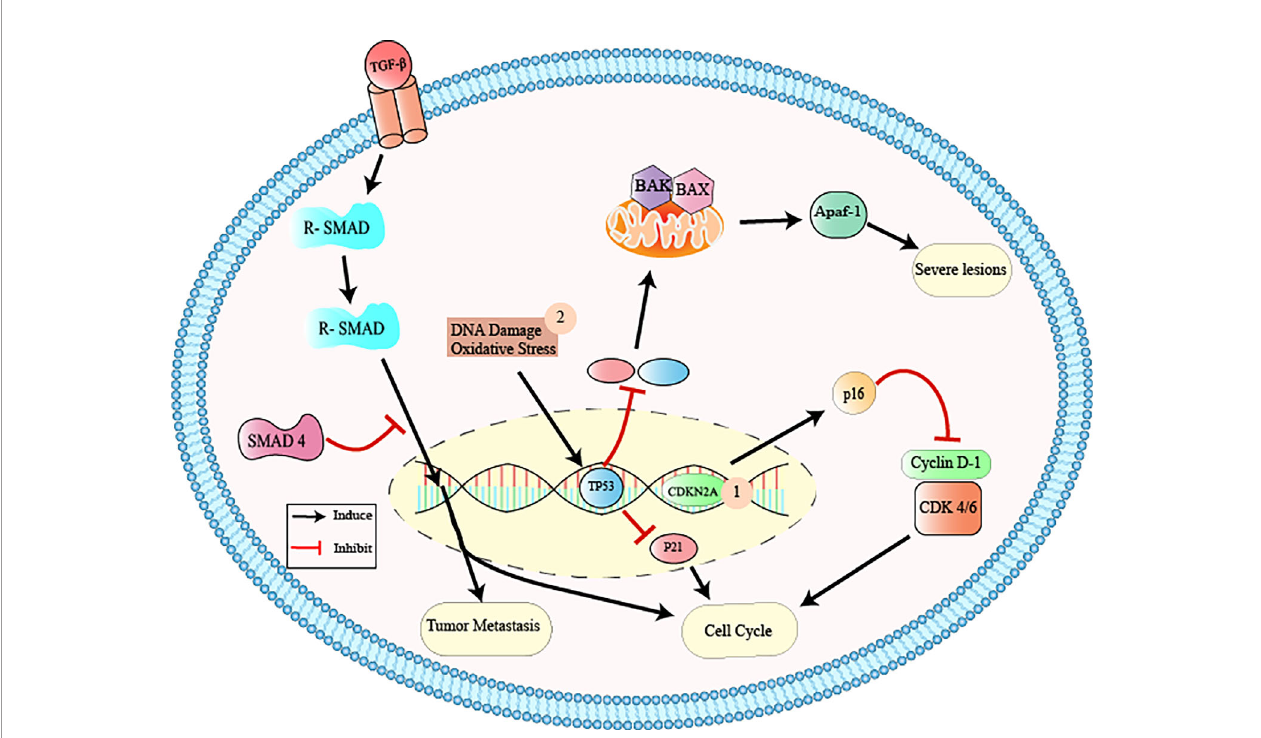
FIGURE 2 | Inactivation of tumor suppressor genes via CDKN2A, TP53, and SMAD4. 1: CDKN2A (cyclin-dependent 2K kinase inhibitor) is a tumor suppressor gene that is found to be mutated usually in PanIN-2 lesions. This gene encodes the p16 protein that binds to cyclin dependent kinase 4/6 (Cdk4/6), interrupting the cell cycle in the G1 phase. The inactivation of CDKN2A causes the functional deactivation of the p16 protein and, consequently, increased cell proliferation, contributing to tumor formation and growth; 2: TP53 (tumor protein p53) is the tumor suppressor gene that activates target genes (p21, Bax, Apaf-1) in response to cell oxidative stress and DNA damage, participating in the control of cell growth and apoptosis through gene transcription. The inactivation of this gene causes dysregulation of the cell cycle and worsening of neoplastic lesions; 3: The SMAD4 (mothers against decapentaplegic homolog 4) is located on chromosome 18q and encodes the beta transcription factor (TGF-b) involved in the regulation of important cellular functions, such as tissue differentiation, cell proliferation, migration, and apoptosis. Inactivation of SMAD4 results in the interruption of the normal cell cycle, contributing to tumor metastasis. From: